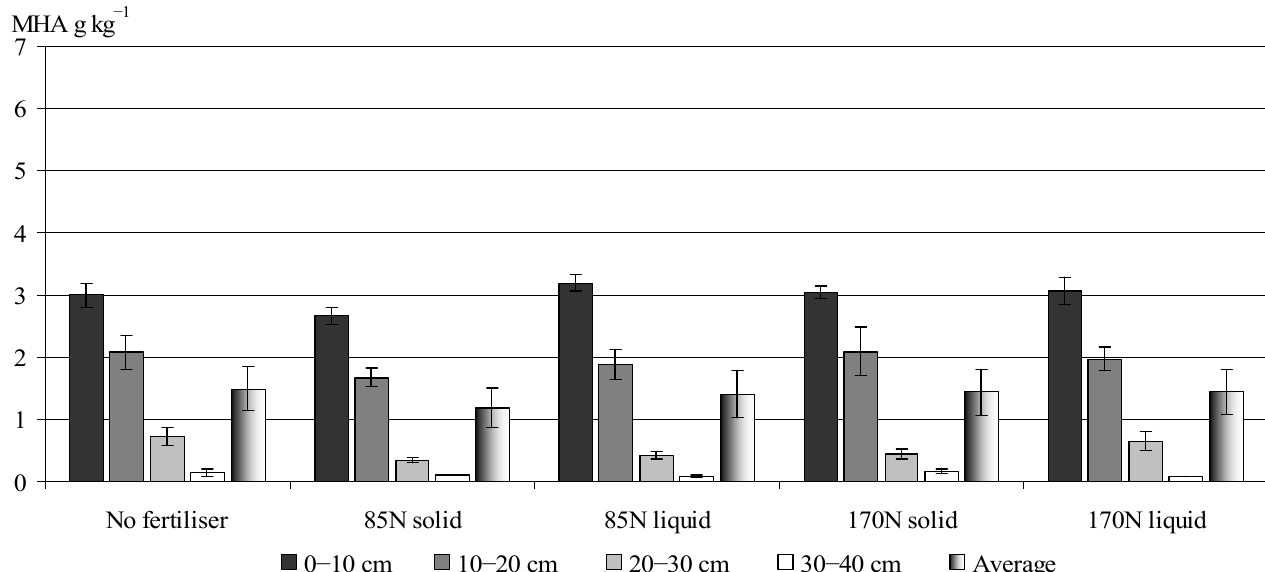
Figure 16. MHS content in grassland in Retisol, 2019.